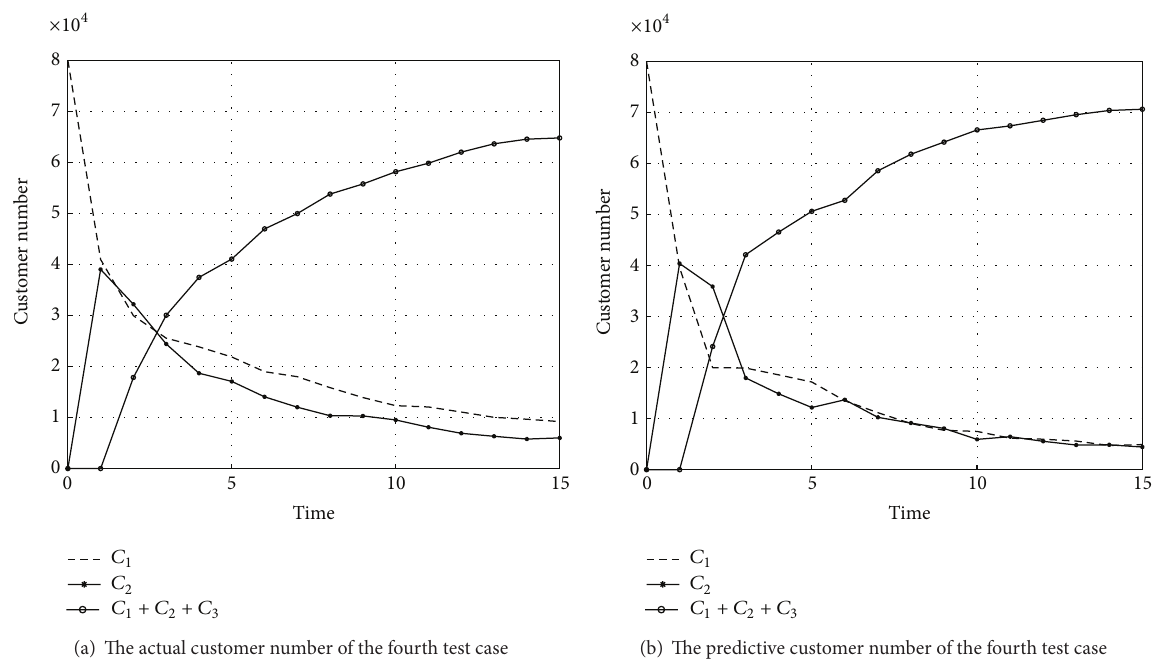
Figure 13: The tendency figure of the actual and predictive customers number of the test case